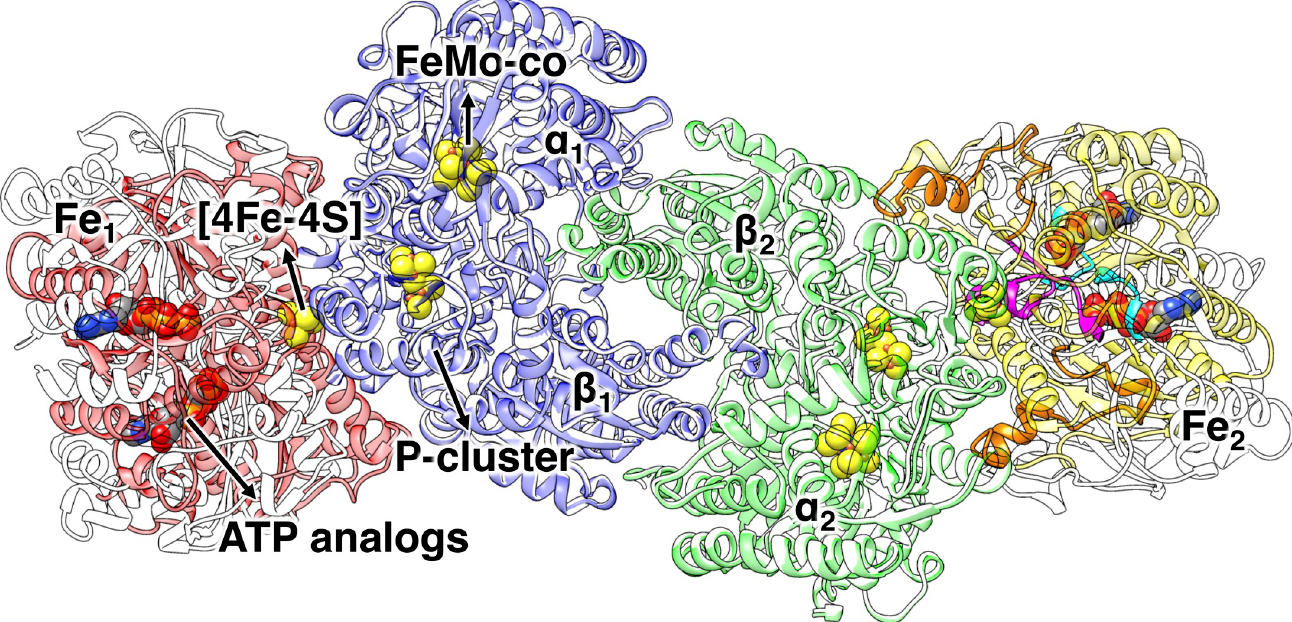
Fig 1. Ribbon representation of the crystal structure of the ATP-bound nitrogenase complex (PDB ID: 2AFK). Fe 1 , red; Fe 2 , yellow; α 1 β 1 unit of MoFe, blue; α 2 β 2 unit of MoFe, green. The ADP-bound complex (PDB ID: 2AFI [I]) shown in white, is aligned to the ATP-bound complex on the MoFe protein. In the ATP- bound complex, the P-loop (cyan), switch I region (orange) and switch II region (magenta) are highlighted in Fe 2 , and the ATP analogues (AMPPCP), [4Fe-4S] clusters, P-clusters and FeMo-co are shown in